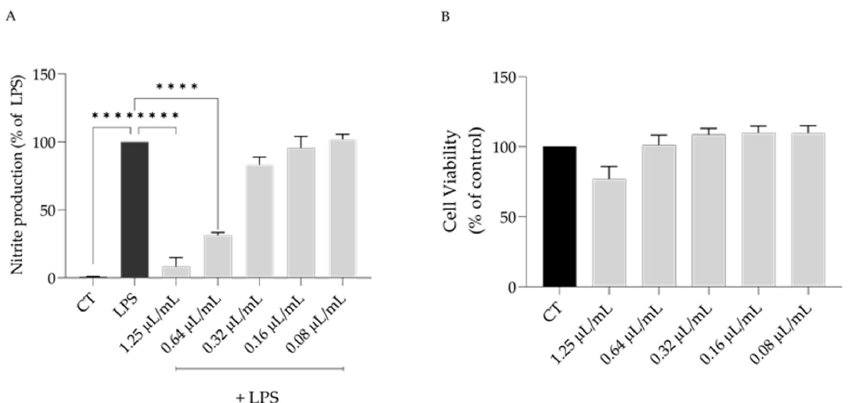
Figure 1. Effect of S. cacaliifolia essential oil on nitrite production ( A ) on LPS-stimulated macrophages after 1 h of pre-treatment with the essential oil followed by 24 h stimulation with LPS and on ( B ) cell viability after 24 h of cells treatment with the essential oil. The results show the mean ± SEM. **** p < 0.0001 when compared to control or LPS after one-way ANOVA followed by Dunnett’s multiple comparison test.